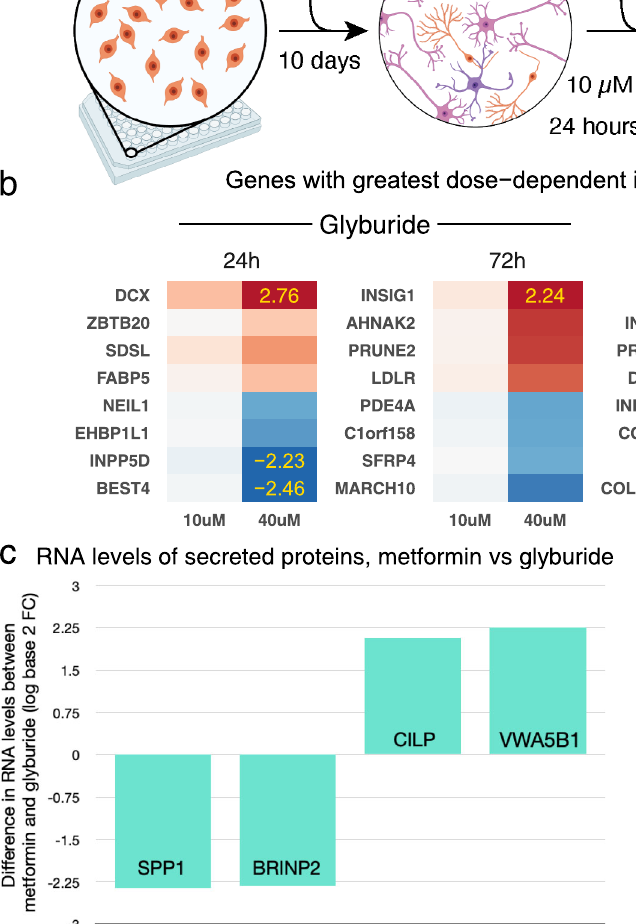
Fig. 5 | Differential gene expression in human neural cells triggered by met- formin and glyburide: markedly reduced levels of the AD biomarker SPP1 (osteopontin).a DifferentiatedhumanReNVMcellsintoneuralcellsweretreated with metformin or glyburideattwodifferent concentrations, for either 24 or 72h. b Genes with largest dose-dependent change in expression over 24 and 72h, for